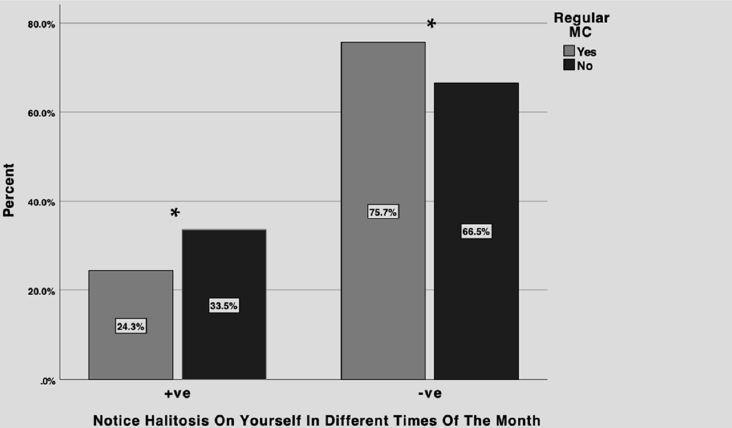
Figure 1. Noticing halitosis on oneself at different times of the month (+ve/yes or − ve/no) of participants who reported regular (grey) versus irregular (black) menstrual cycles. More females with irregular menstrual cycle reported halitosis at different time of the month compared to those with regular menstrual cycles. The majority of the female with regular menstrual cycle reported that they do not notice halitosis at different times of the month. The differences between groups were statistically significant (* p < 0.05). Table 5. Association of several questionnaire domains: (1) halitosis self-perception, (2) history of sinusitis, periodontal diseases, and smoking, (3) halitosis oral symptoms, (4) halitosis social impact, (5) menstrual cycle halitosis perception with categories of reported hormonal disturbances, namely, suffering from hormonal disturbances, not suffering from hormonal disturbances, and do not